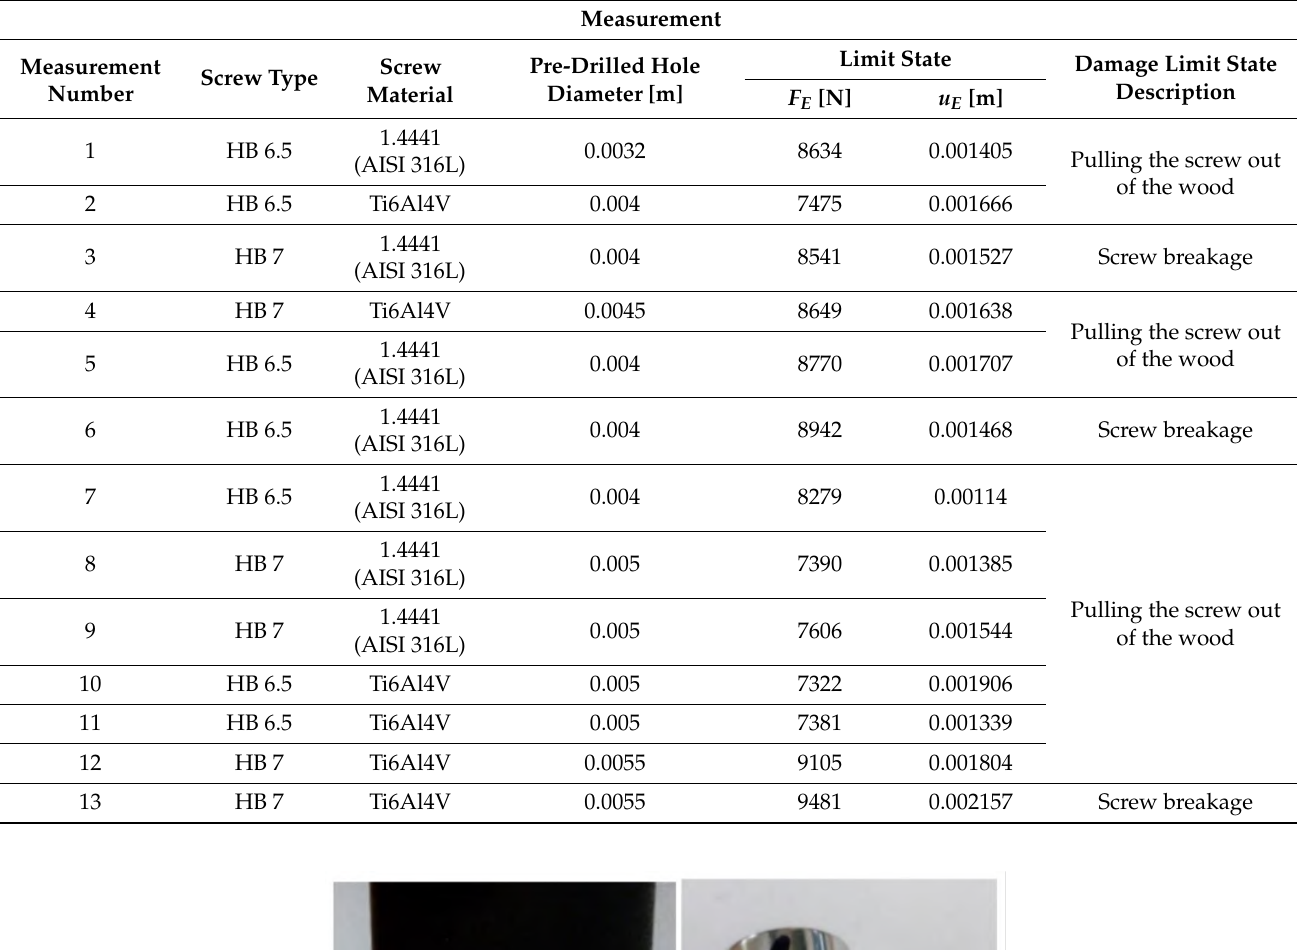
Table 3. Pull-out test results ( Picea abies wood, moisture about 10%).